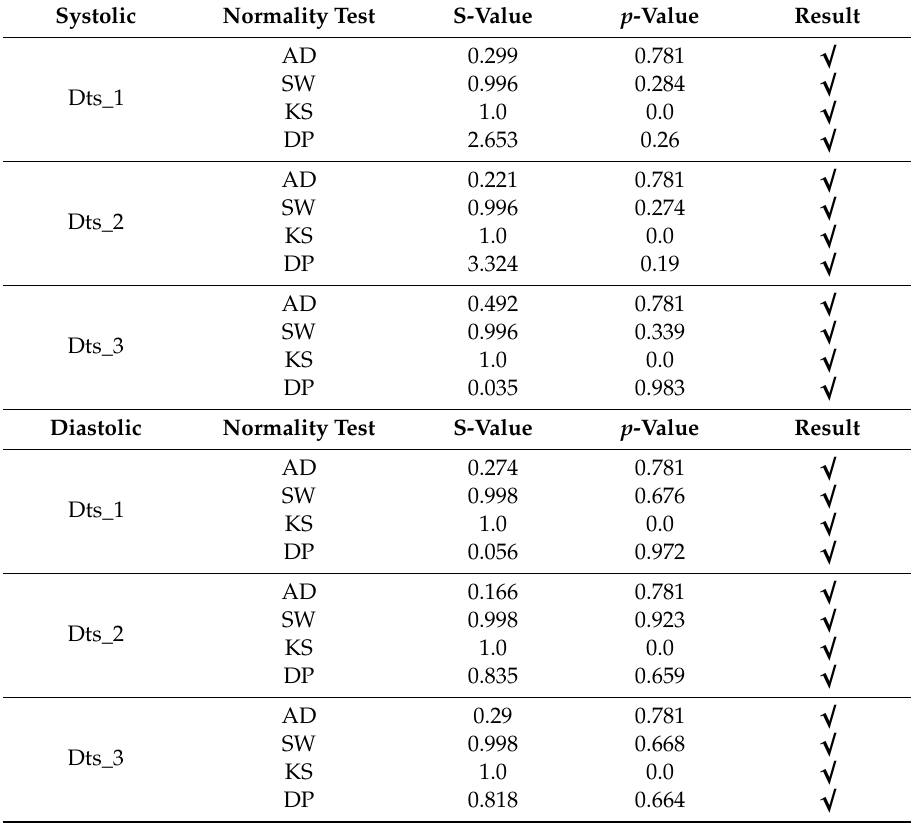
Table 11. Results of normality tests using statistical